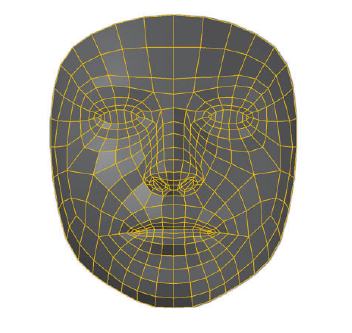
Figure 2. MediaPipe Face Mesh predicted topology